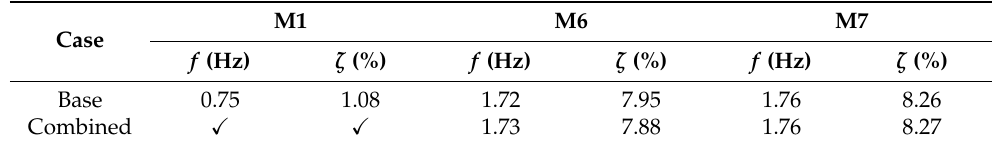
Table 19. Comparison between the base case and the combined contribution of RESs frequency support and PSS tuning to the small signal stability for the Lines out of Service DP. Check marks indicate those modes with a damping factor greater than